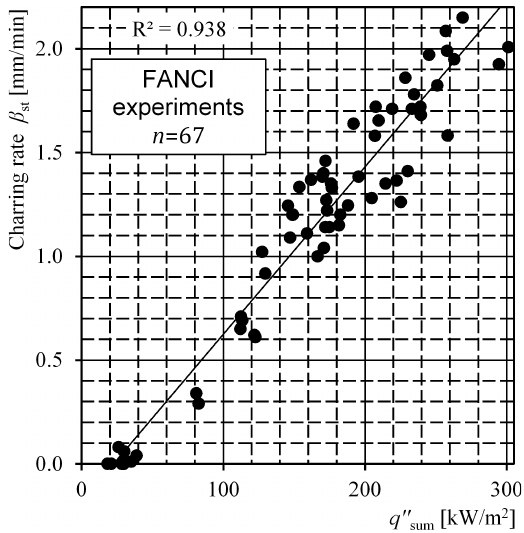
Figure 8: Observed charring rate vs. the superimposed heat flux and the correlation coeflcient (least squares method).